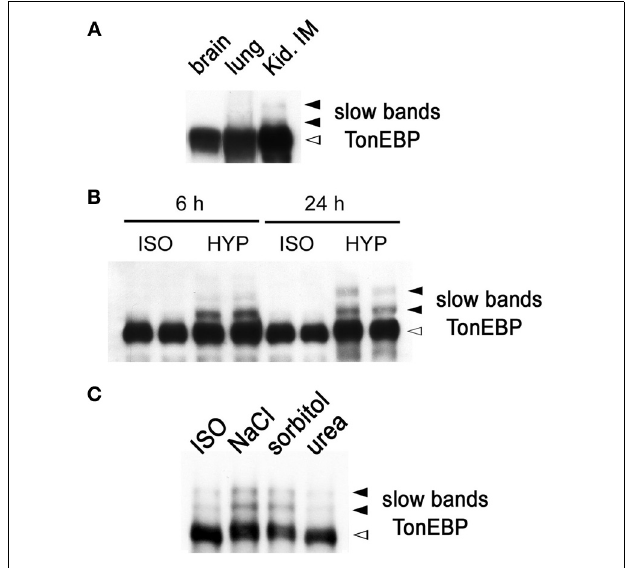
FIGURE 1 | Slow TonEBP bands in the kidney and HEK293 cells cultured in hypertonicity. (A) A representative TonEBP immunoblot of brain, lung, and kidney inner medulla (Kid. IM) obtained from three euhydrated rats. Urine osmolality was 1730 ± 60 mosmol/kg. (B) TonEBP immunoblot of HEK293 cells cultured in isotonic (ISO) or hypertonic medium (HYP) for 6 or 24h. (C) TonEBP immunoblot of HEK293 cells cultured in hyperosmotic medium containing additional 100mM NaCl (NaCl), 200mM sorbitol (sorbitol), and 200mM urea (urea) for 6h. TonEBP and slow bands are indicated on the right. The slow bands are 16 and 32kDa larger than the TonEBP